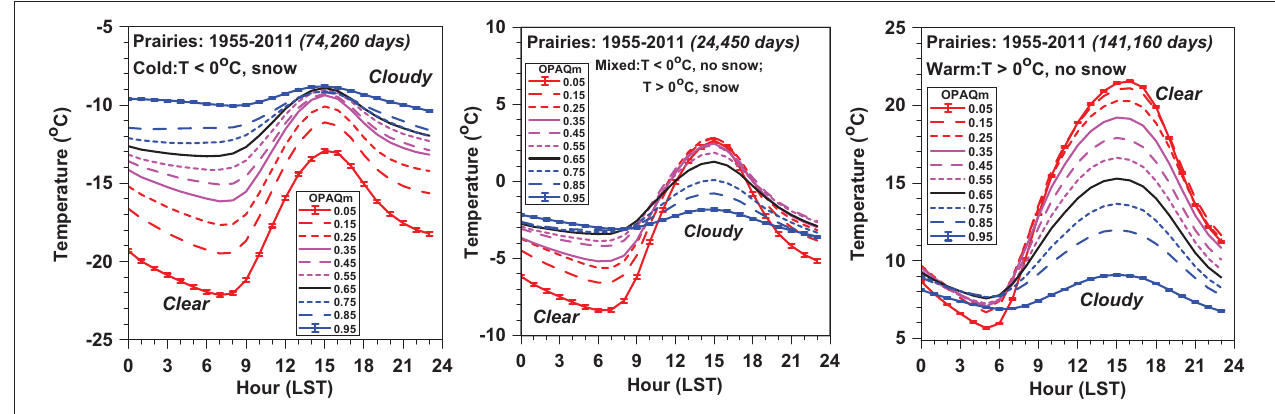
FIGURE 7 | Diurnal cycle of temperature stratified by OPAQ m for cold season with snow cover, mixed regime and warm season without snow cover.